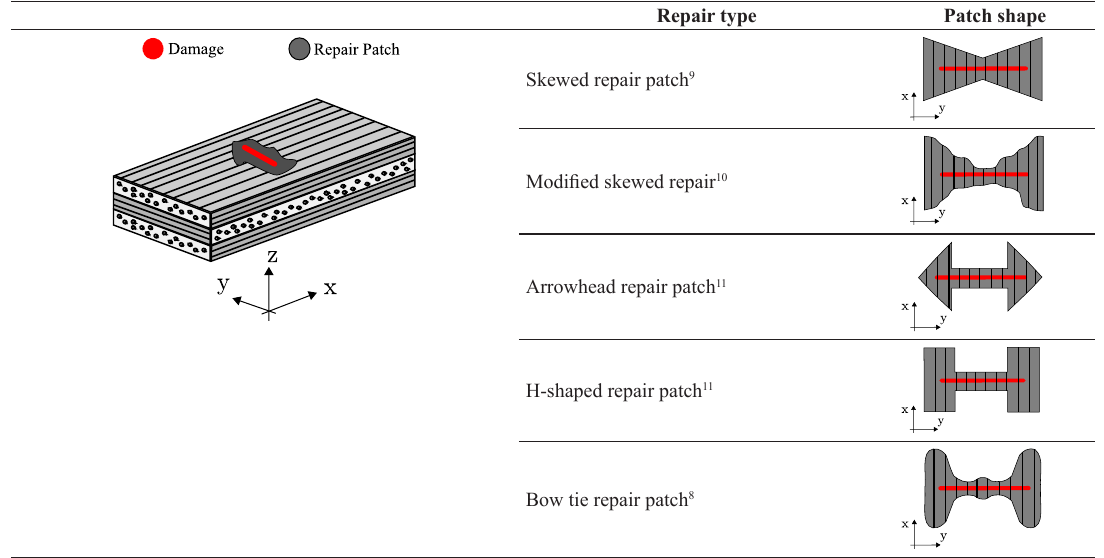
Table 1. Different repair patch